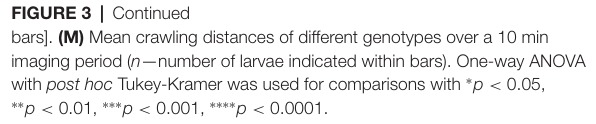
Figure 3L ]. However, following pharmacological